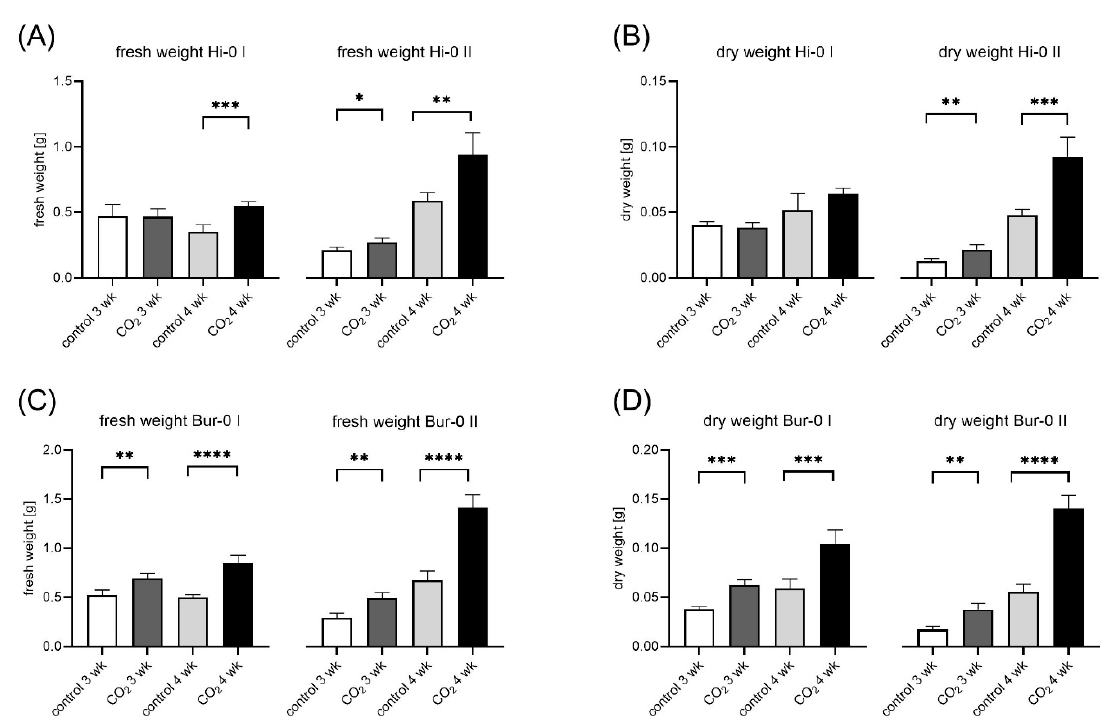
Fig. 1: Primary production of biomass under elevated CO 2 concentrations. (A) Fresh weight and (B) dry weight of plants from A. thaliana accession Hi-0 and (C) fresh weight and (D) dry weight of plants from A. thaliana accession Bur-0 under elevated (2%) [CO 2 ] (dark bars) and ambient air (0.04% [CO 2 ]) (light bars) after three and four weeks (wk). Averages and standard deviations of biological replicates (n = 4-5) are shown for two experimental replications (I and II) separately. Significant differences between CO 2 treated and control group were signed with *, p < 0.05; **, p < 0.01; ***, p < 0.005 (unpaired